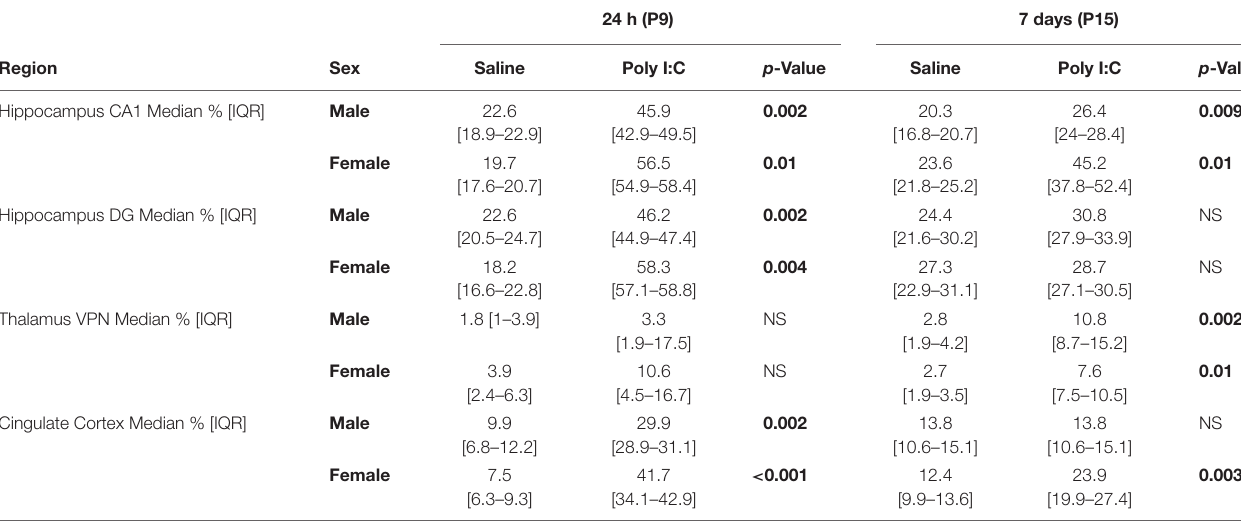
TABLE 2 | Percent area of GFAP immunostaining per region.